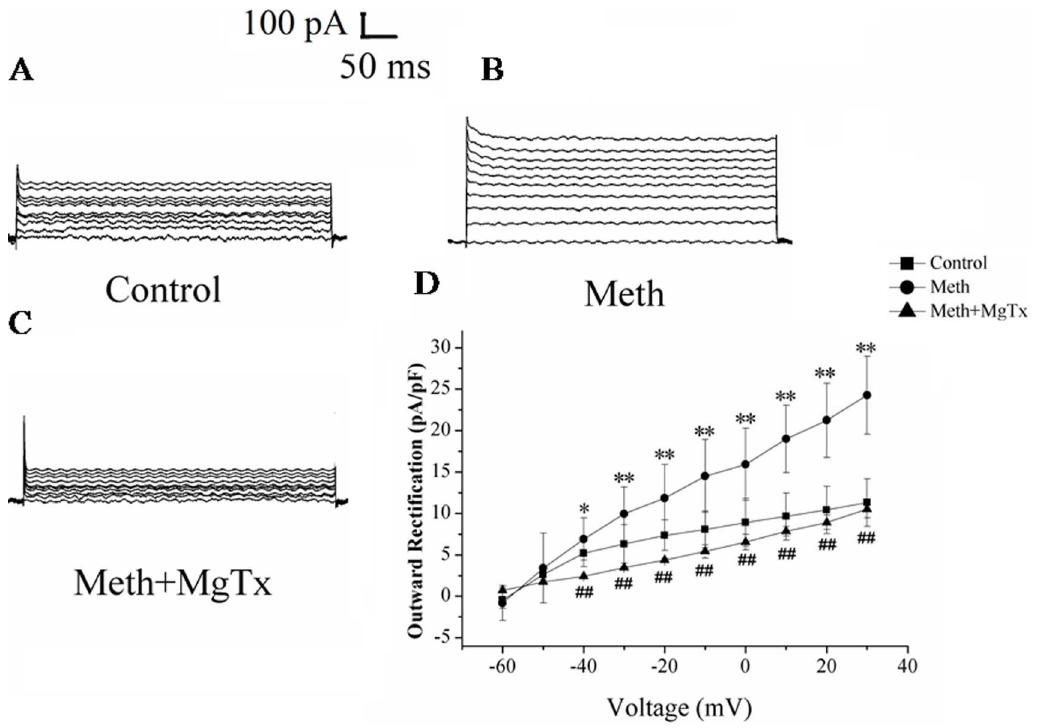
Figure 1. Meth significantly enhanced the outward K + currents. The microglial cells were incubated with Meth (100 m M) for 24 h, then the K + currents were recorded in (A) control group. (B) Meth treated group. (C) MgTx application before recording in Meth treated group. (D) The I–V plots of the K + current density of microglial cells activated by voltage steps increments from a holding potential of 2 70 mV with intervals from 2 70 mV to + 30 mV during 500 ms. *p , 0.05 compared with control group